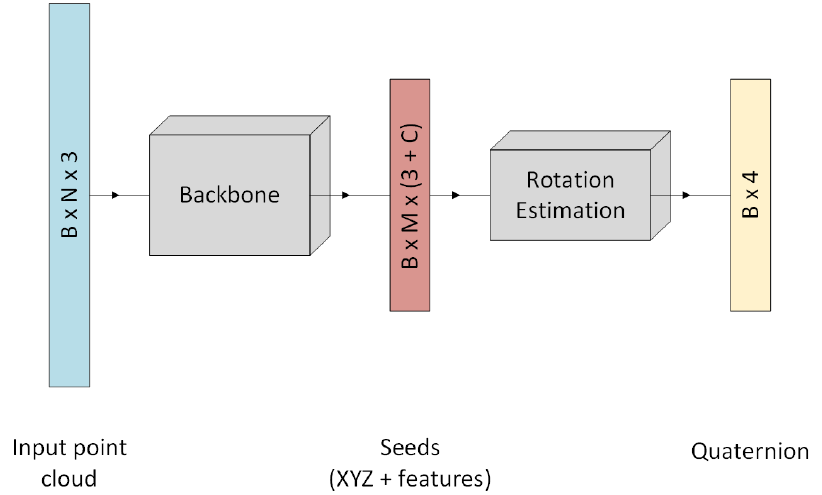
Figure 7. Overview of P2R-Net architecture. N is the number of points, B refers to the batch size of the network, M is the number of seed points and C is the number of additional features found by the network.